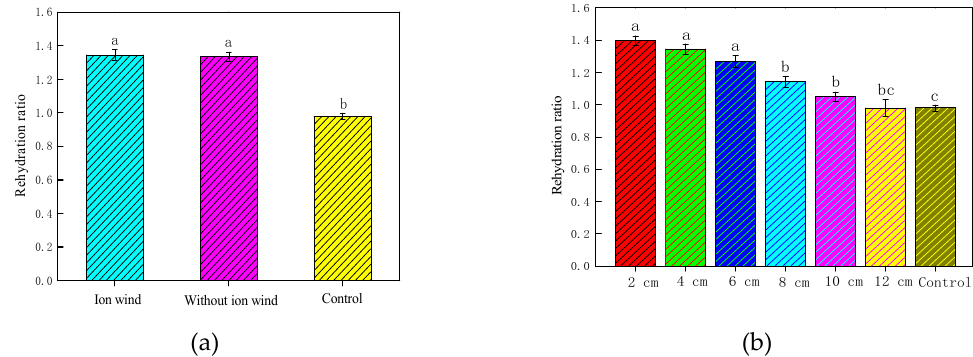
Figure 5. The rehydration rate of Chinese wolfberry fruits. ( a ) Ionic wind and without ionic wind; ( b ) different needle spacing. Data are shown as the mean ± SD. For each response, means with different lower-case letters are significantly different ( p < 0.05).